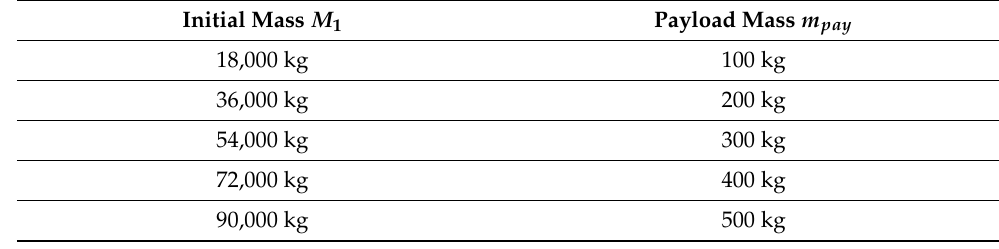
Table 2. Minimumlift-off mass to inject the payload mass into circular polar orbit of altitude h = 650km (average parameters (5) and (6), and launch site L = 30 deg).